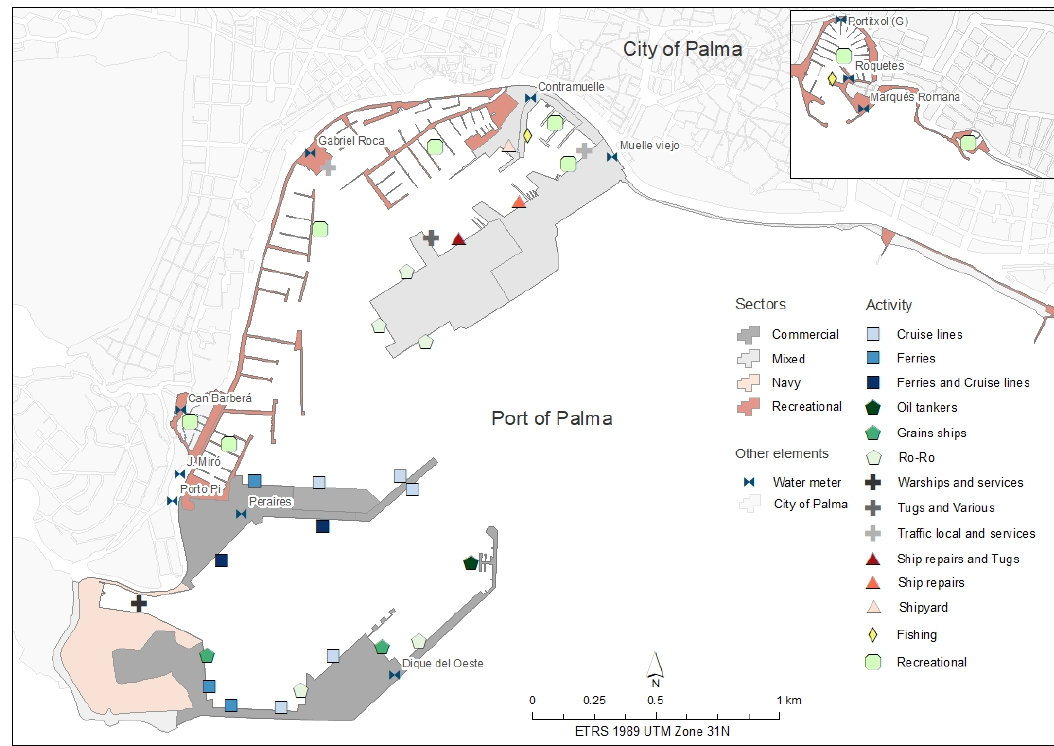
Figure 2. Classification of sectors in the Port of Palma according to activities and linked to the water meters installed.